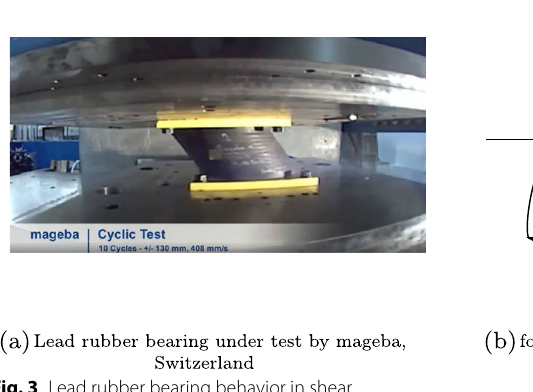
Fig. 3 Lead rubber bearing behavior in